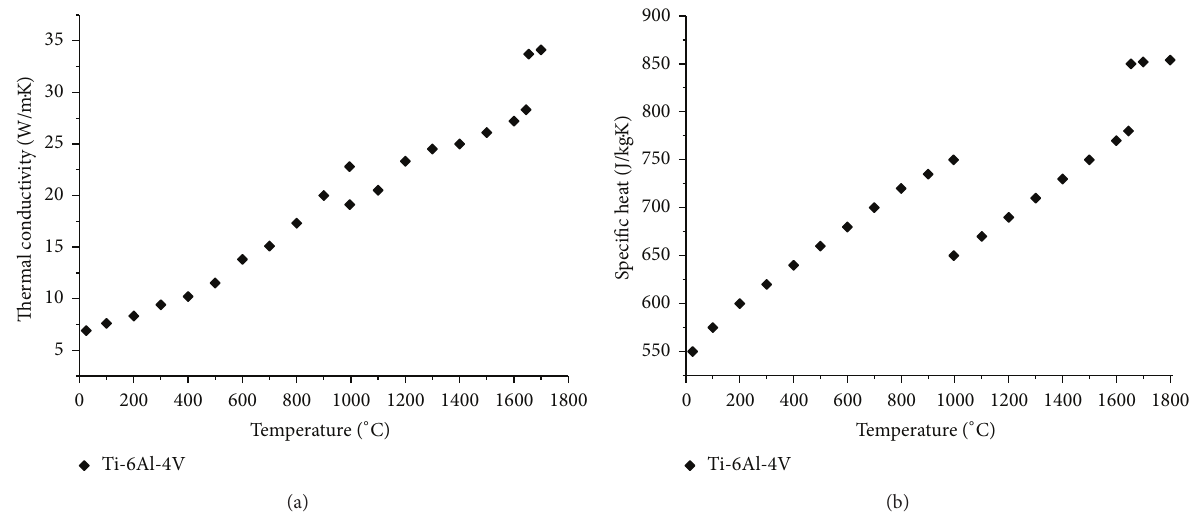
Figure 3: Titanium alloy data available within the literature [17] for (top) thermal conductivity and (bottom) specific heat.